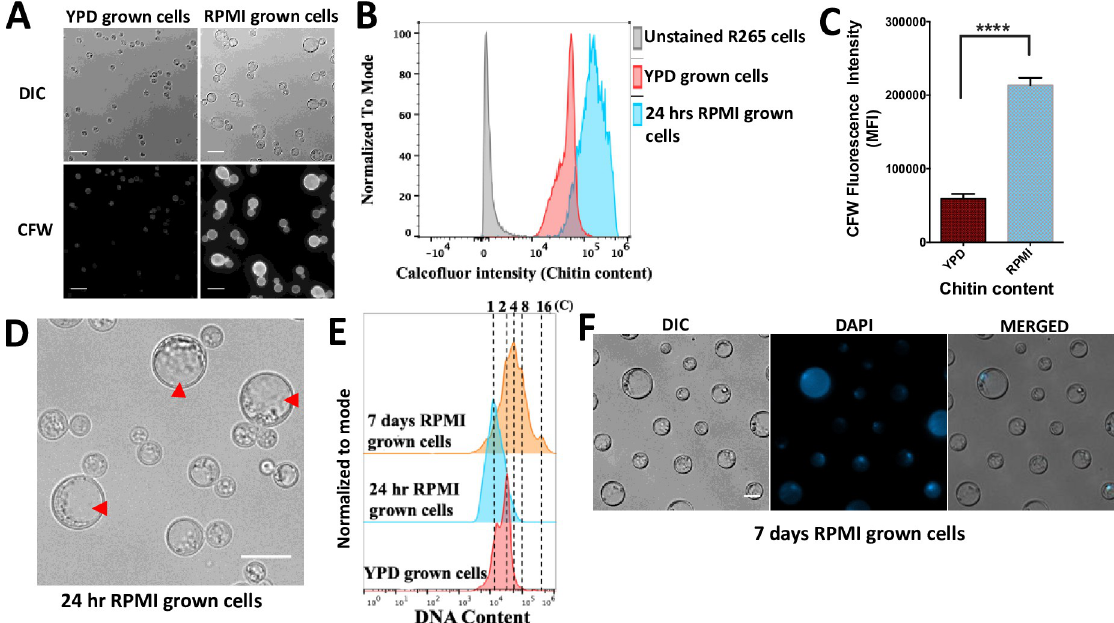
Fig 2. The cell wall chitin content and ploidy of enlarged cells are typical of titan cells. In vitro RPMI - generated enlarged cells displayed a significantly higher chitin level relative to YPD grown R265 cells, as indicated by the calcofluor white (CFW) fluorescence intensity shown using microscopy imaging in (A), via flow cytometry in (B) and graphically in (C, Median Fluorescence Intensity, MFI) (p < 0.0001). Scale bar = 15 μ m. Statistical significance was confirmed by Two-tailed t- test. D) Micrograph showing single large central vacuole of in vitro- generated enlarged cells. E) Ploidy measurement of RPMI-generated enlarged cells based on flow cytometry analysis of DAPI staining. YPD grown cells (red) gated as 1C, 2C (haploid) were used as a control to determine ploidy (DNA content) of enlarged cells after 24 hr (blue) and 7 days (orange) of induction. F) Micrographs showing the uninucleate nature of R265 titan cells upon staining with DAPI to visualize the nucleus. Scale bar = 10 μ m.